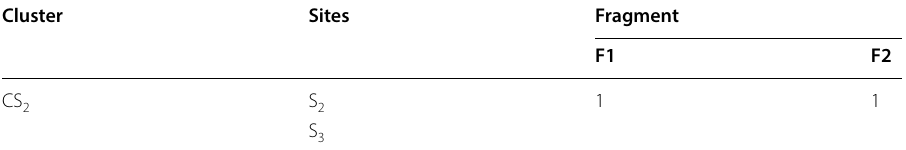
Table 21 Scenario (2)—the final allocation of data fragment Cluster Sites